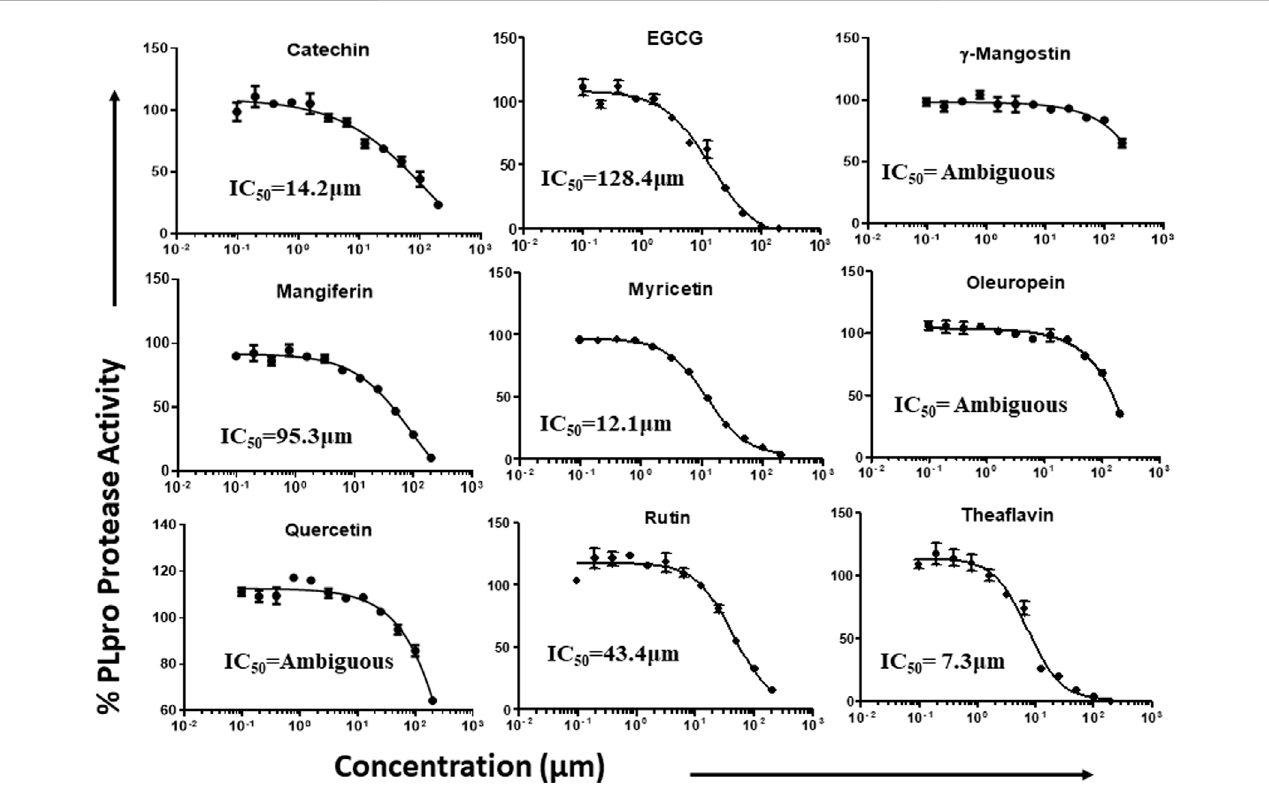
FIGURE 5 Dose-dependentinhibitionofSARS-CoV-2PLproproteolyticactivitybyEGCG,catechin,myricetin,mangiferin,and γ -mangostin,oleuropein,quercetin, rutin, and thea fl avin: The phytochemicals that exhibited at least 50% inhibition of proteolytic activity of PLpro enzyme were selected and screened for their dose-dependentinhibitoryactivityasdescribedunderMaterialsandMethods.The fl uorescenceintensitywasusedtocalculatethepercentenzymaticactivity considering DMSO treated control as 100% activity. Blank values were subtracted before calculating the percent activity. Representatives of four individual experiments (n = 4) with triplicate values were analyzed using GraphPad Prism8 and presented graphically. IC50 values were calculated using non- linear regression (curve fi t) with four variable dose vs . inhibition by GraphPad